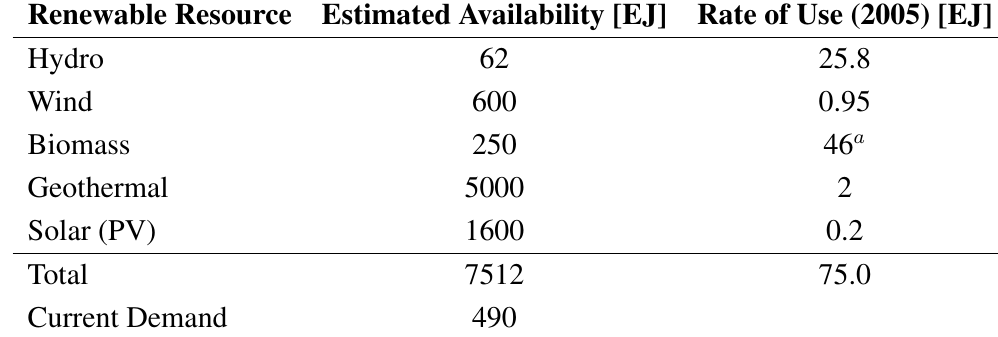
Table 1 . Energy demand and availability of main renewable resources on annual basis (adapted from [6]).